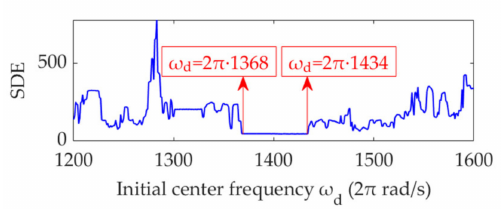
Figure 23. Relationship between the initial center frequency, ω d , and SDE